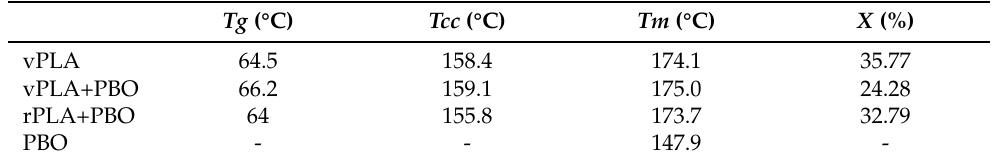
Table 4. Thermal properties determined from the DSC thermograms for virgin PLA (vPLA), virgin PLA mixed in the presence of PBO (vPLA+PBO), and recycled PLA mixed in the presence of PBO (rPLA+PBO).